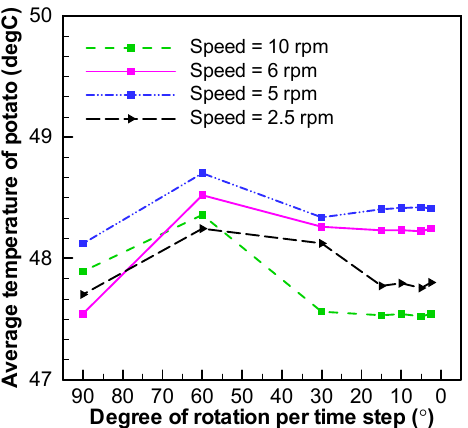
Figure 4. Average temperature of potato slice at different rotation angles per time step under different speeds.